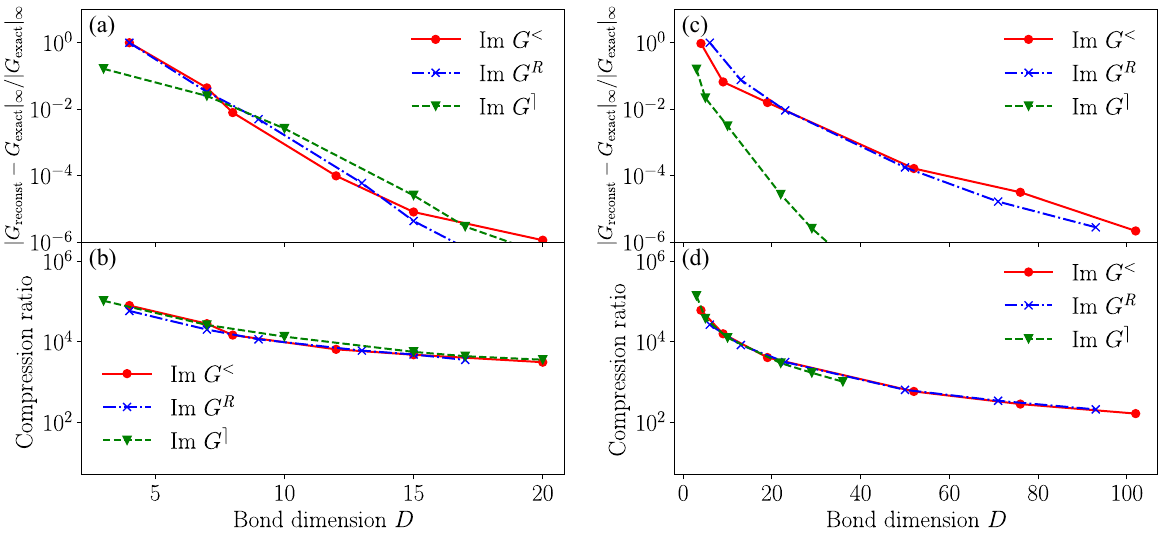
FIG. 21. Scaling of the relative accuracy [panels (a) and (c)] and compression ratio [panels (b) and (d)] for the different components of the Green ’ s function. The left panels are for the equilibrium case and the right panels for the nonequilibrium case. The symbol j (cid:2) (cid:2) (cid:2) j ∞ denotes the maximum norm of a